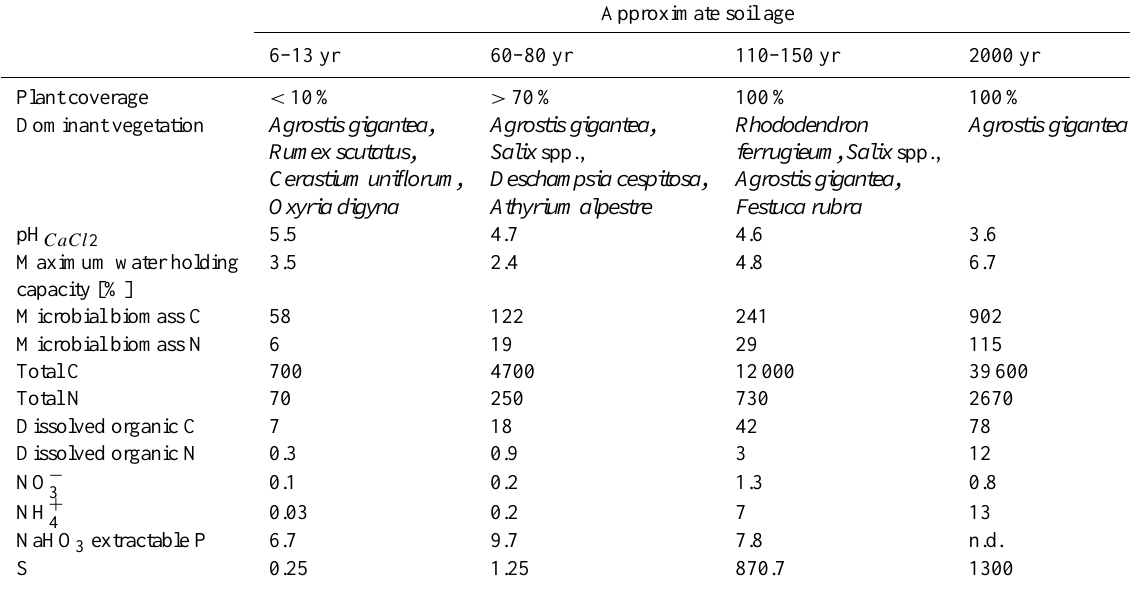
Table 1. Plant and soil parameters from initial (6–13yr), transient (60-80yr) and developed (110-150 yr) sites and a reference site ( > 2000yr) outside the glacier forefield. All nutrient values and the microbial biomass C are given in µgg − 1 . Data were summarized from Bernasconi et al. (2011), Brankatschk et al. (2011), G¨oransson et al. (2011), H¨ammerli et al. (2007) and Noll and Wellinger